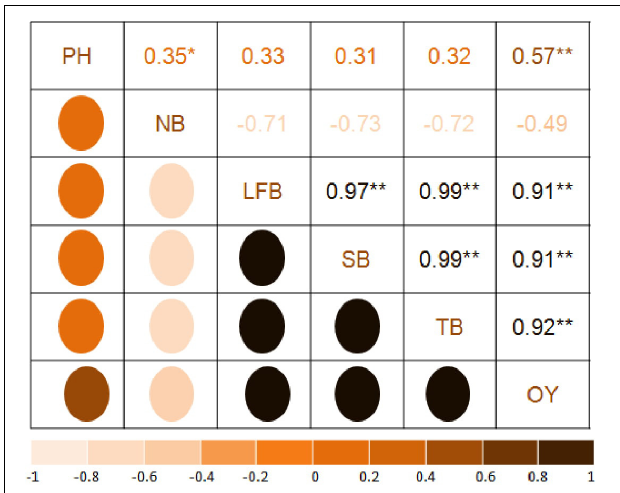
FIGURE 2 | Correlation analysis of growth and yield parameters. PH, plant height; NB, number of branches per plant; LFB, leaf+flower biomass; SB, stem biomass; TB, total biomass. OY, oil yield. The mean values of the 2 years pooled data of the corresponding treatments are used (where N1 = N2 =